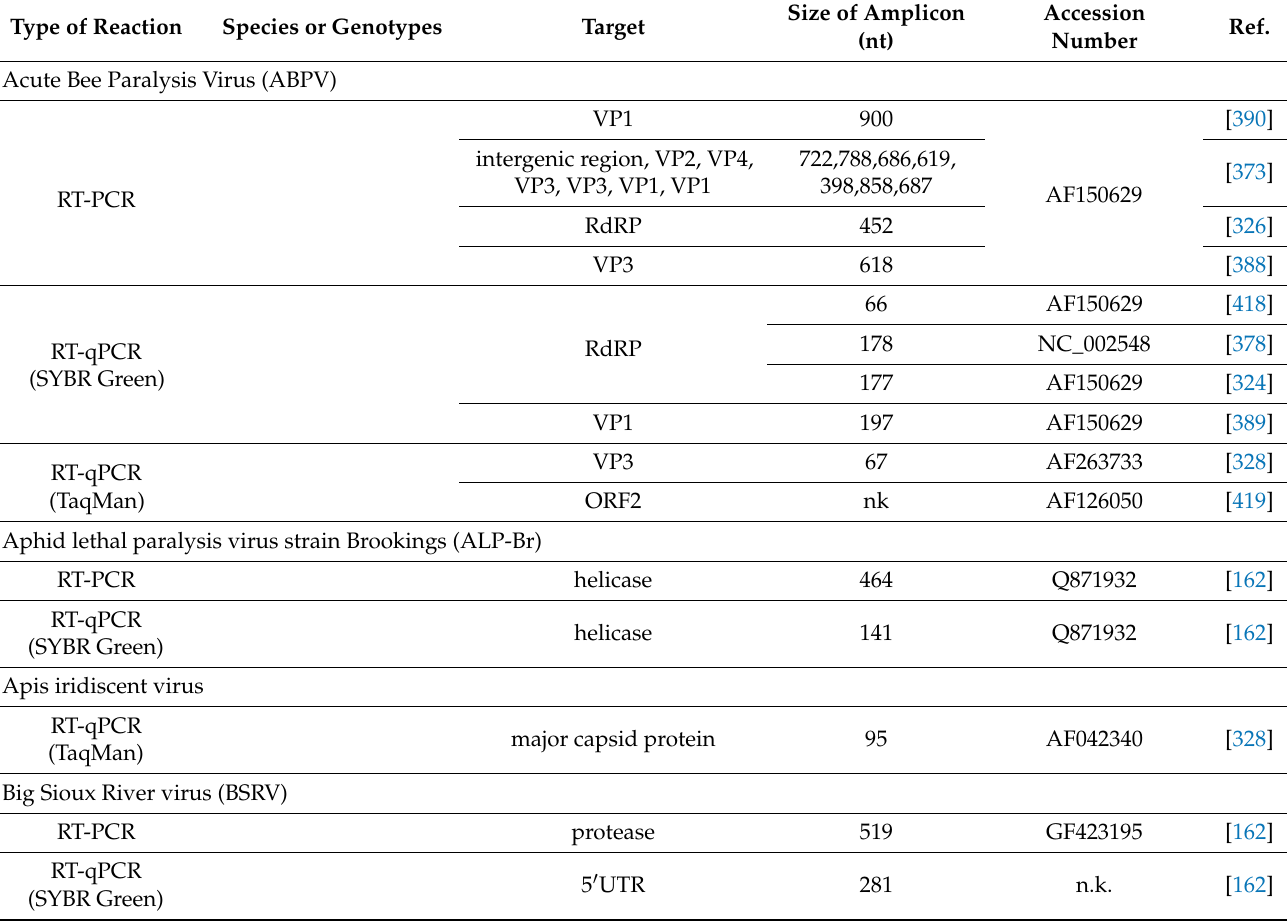
Table 5. Molecular diagnostics for detection and variant differentiation of viruses that infect honey-